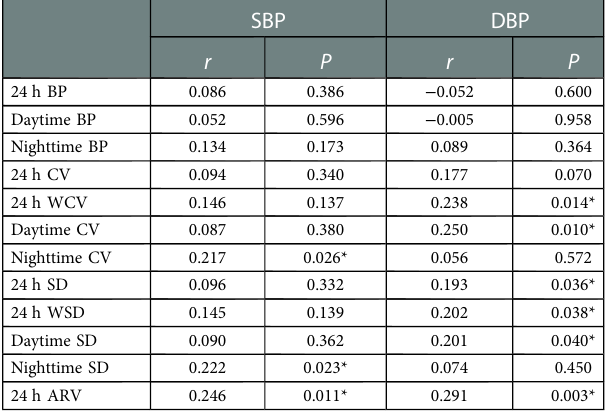
TABLE 2 Correlation between napping duration and 24 h ABPM parameters.